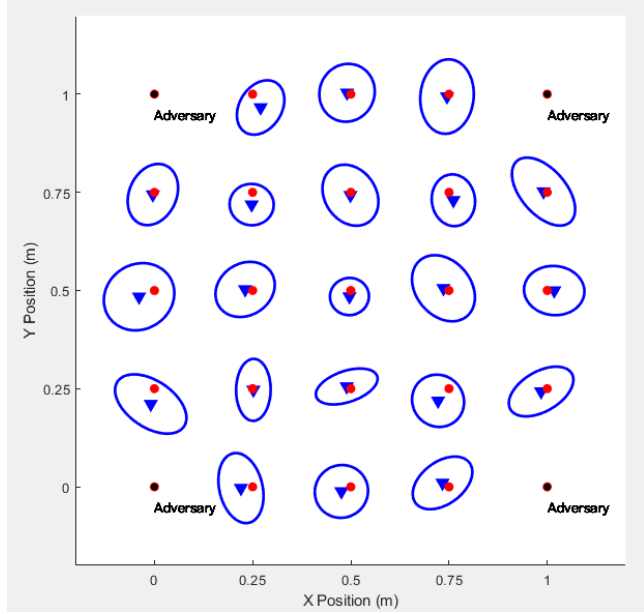
Figure 10. The Adversities Cannot Obtain the